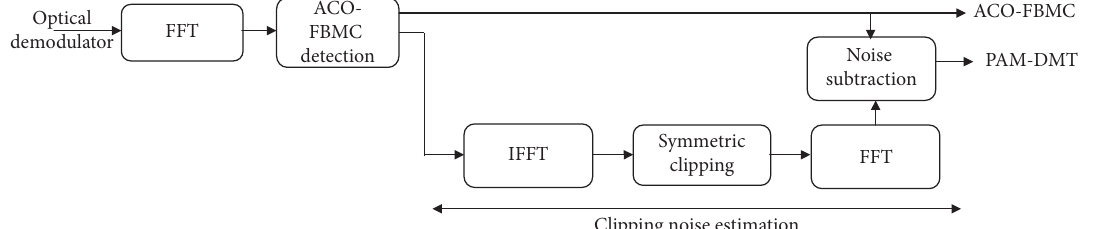
Figure 3: Block diagram of ACO-FBMC and PAM-DMT